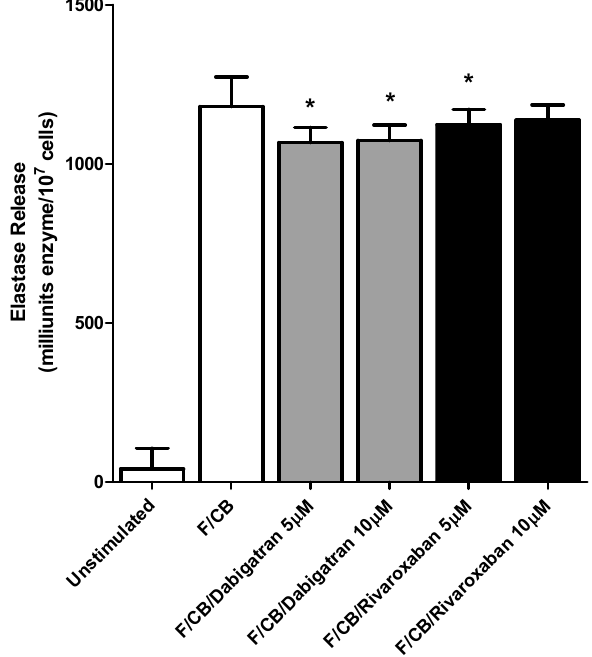
Figure 2. Effects of dabigatran and rivaroxaban (5 and 10 µM) on the release of elastase from N - formyl- L -methionyl- L -leucyl- L -phenylalanine/cytochalasin B (fMLP/CB) (1 µM/0.5 µM)-activated human neutrophils. The results of four different experiments using cells from four different donors are expressed as the mean values ± SEMs as milliunits enzyme/10 7 cells. * p < 0.008– p < 0.04.